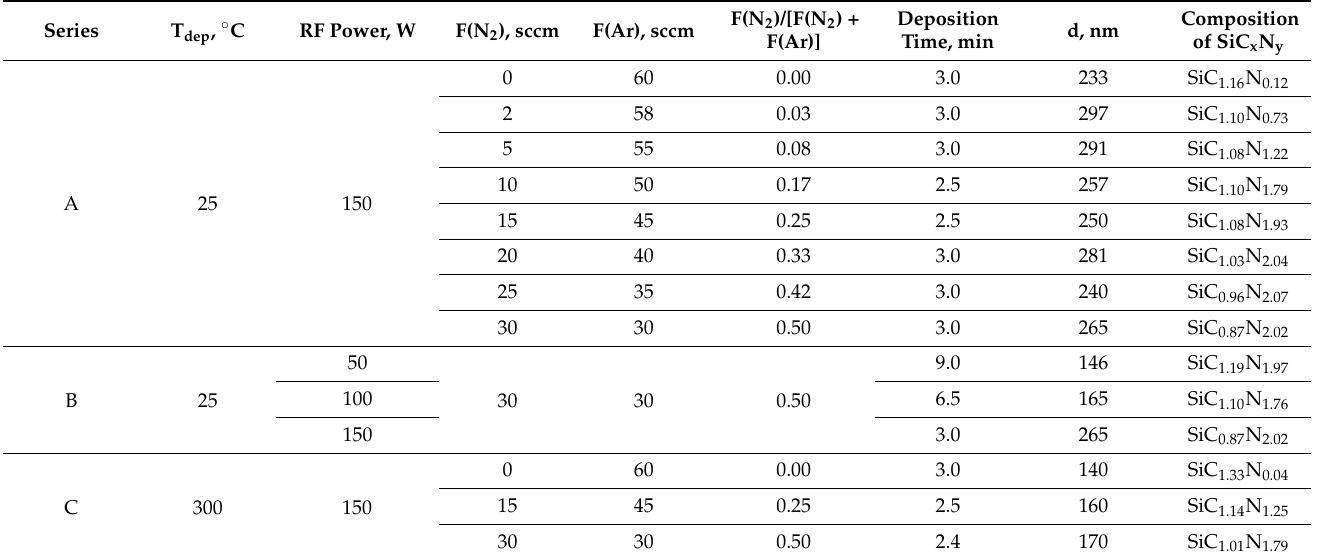
Table 3. Experimental conditions and chemical composition of MS SiC x N y